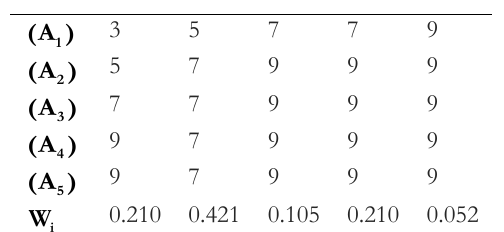
Table 4. Decision matrix.